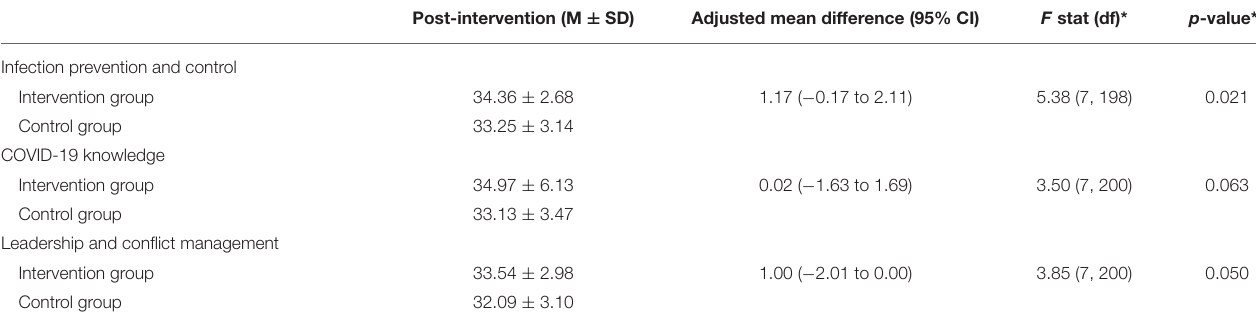
TABLE 6 | ANCOVA results for the three study domains for the control and intervention group after controlling for confounding variables ( n =